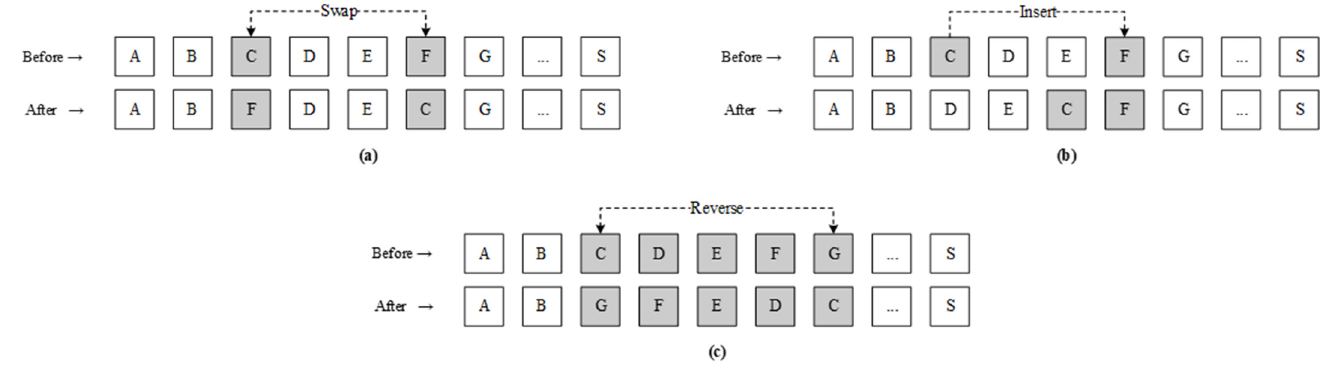
Figure 3. Mutation operation: ( a ) swap operator, ( b ) insert operator and ( c ) reverse operator .